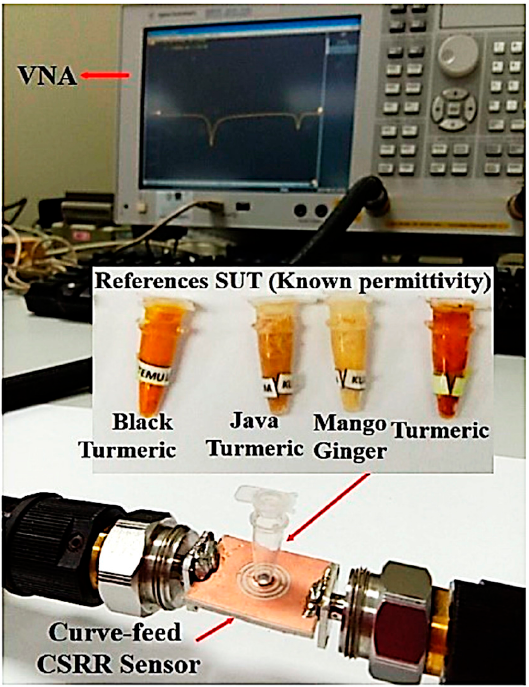
Figure 16. The SUTs experimental validation for the triple-rings CSRR sensor.